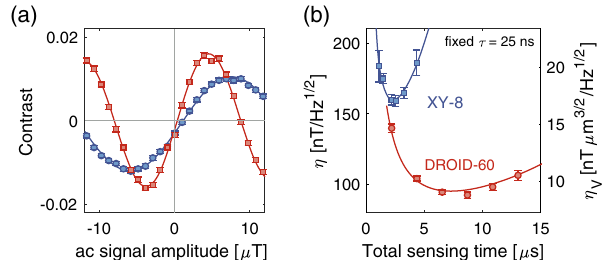
FIG. 4. Demonstration of sensitivity enhancement. (a) Observed spin contrast as a function of ac magnetic field strength, for the XY-8 sequence (blue) and for DROID-60 (red). The fit is a sinusoidal oscillation with an exponentially decaying profile [17]. Sequence B shows a steeper slope at zero field, indicating that it is more sensitive than XY-8 to the external field. The interrogation times, t ¼ 2 . 16 μ s for XY-8 and t ¼ 6 . 52 μ s for DROID-60, are independently optimized to achieve maximal sensitivity [17]. (b) Extracted absolute sensitivity η and volume-normalized ffiffiffiffi p V sensitivity η V ¼ η with sensing volume V ¼ 8 . 1 ð 9 Þ × 10 − 3 μ m 3 as a function of phase accumulation time t (error bars are given for η ). The pulse spacing τ is fixed at 25 ns to detect the ac signal oscillating at frequency 11 MHz [see Fig. 3(d)]. A comparison of the two sequences at their respective optimal sensing times reveals that DROID-60 outperforms XY-8 by ∼ 40% . The solid lines indicate the theoretical sensitivity scaling using the independently estimated sensor characteristics